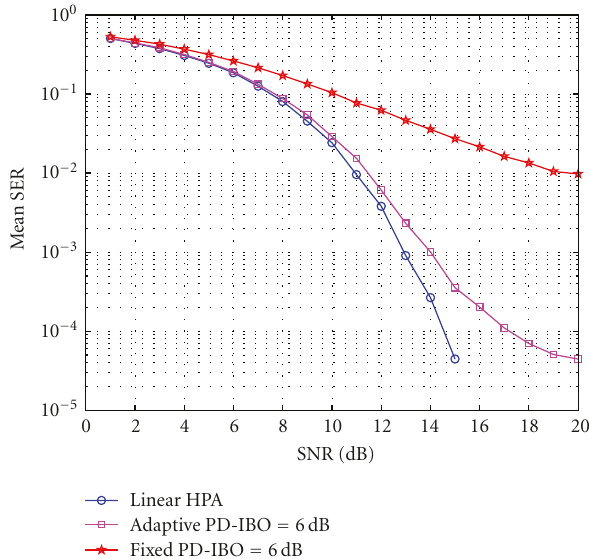
Figure 16: SER performance of PD in OFDM, with time-varying TWTA, IBO = 6